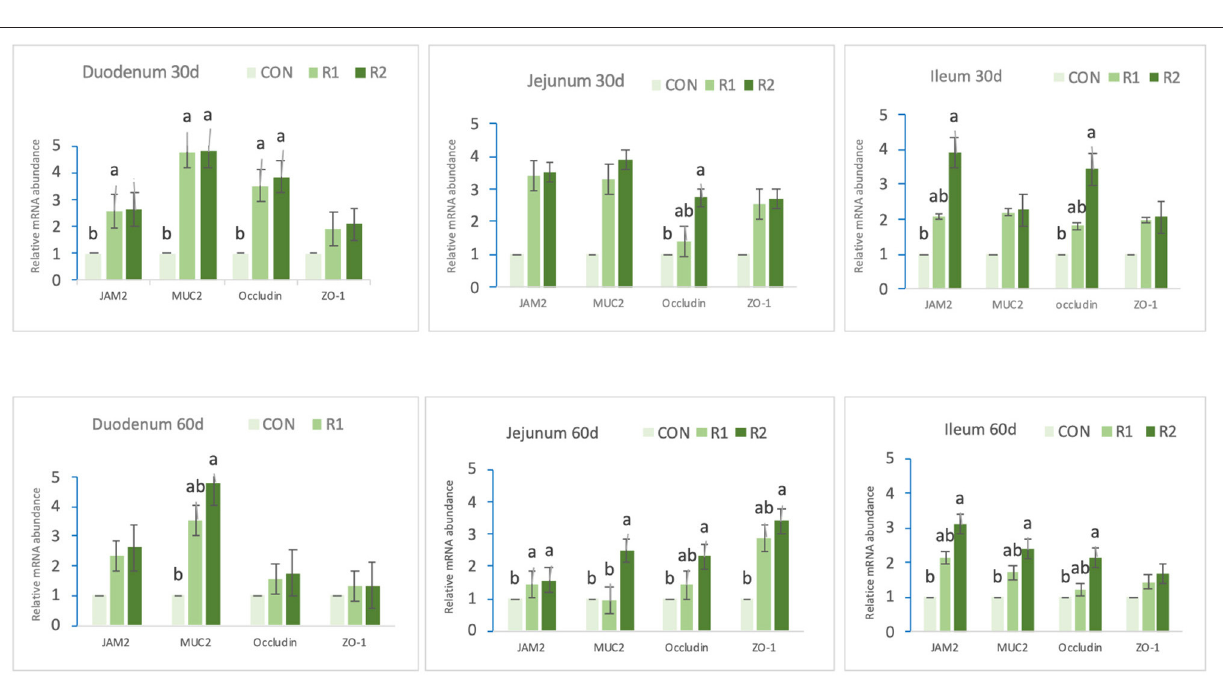
FIGURE 2 | Effects of dietary catalase supply on tight junction protein mRNA expression in the intestinal mucosa of yellow broilers. Data are the mean ± SEM ( n = 8). CON-broilers fed the basal diet, R1-broilers fed the basal diet supplemented with 150 U/kg CAT, R2-broilers fed the basal diet supplemented with 200 U/kg CAT a,b,c within the same intestinal segment and the same protein, means with different superscript letters differ ( p <